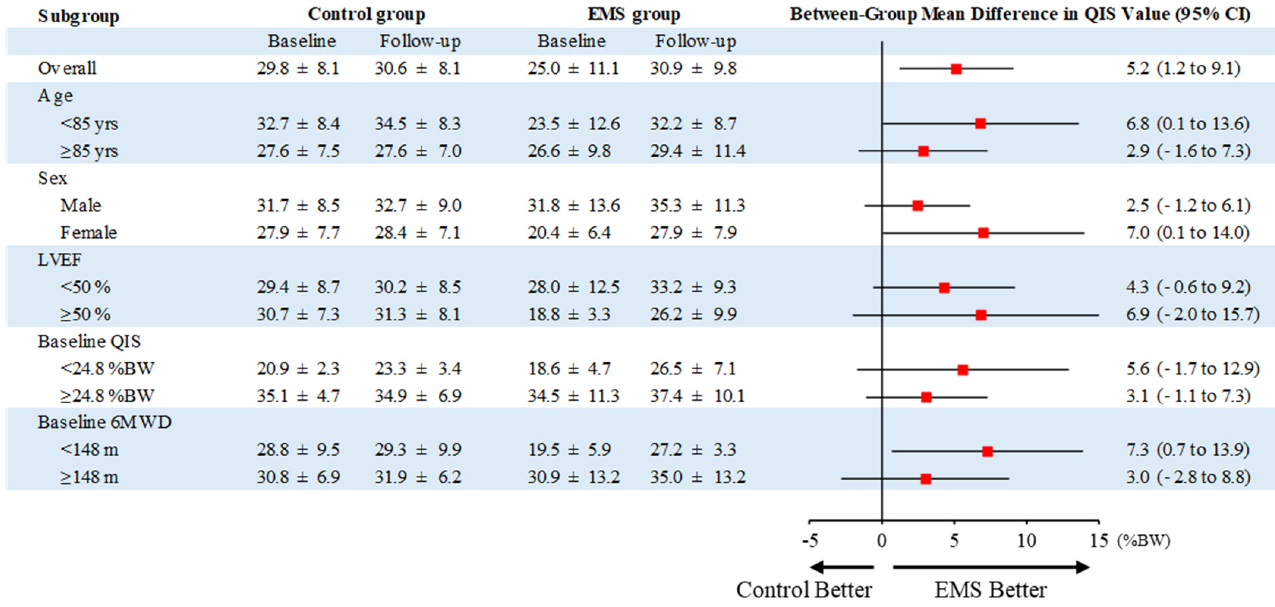
Figure 4. Prespecified subgroup analysis of the primary outcome. Values are expressed as means ± SD. BW, body weight; CI, confidence interval; EMS, electrical muscle stimulation; LVEF, left ventricular ejection fraction; QIS, quadriceps isometric strength; 6MWD, 6-min walking distance. Table 2. Association between the changes in cardiovascular and functional parameters.